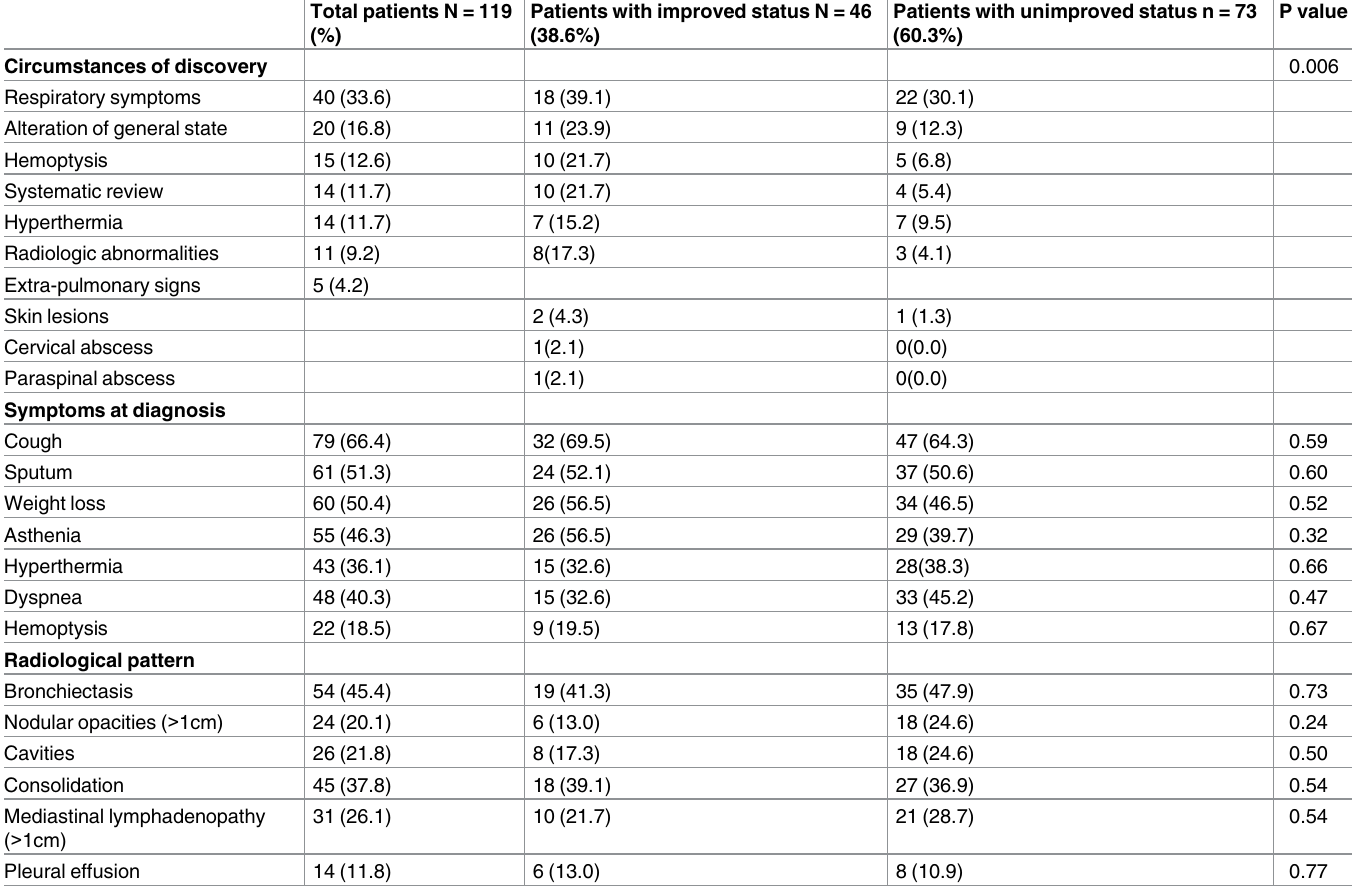
Table 2. Clinical and radiological characteristics of patients